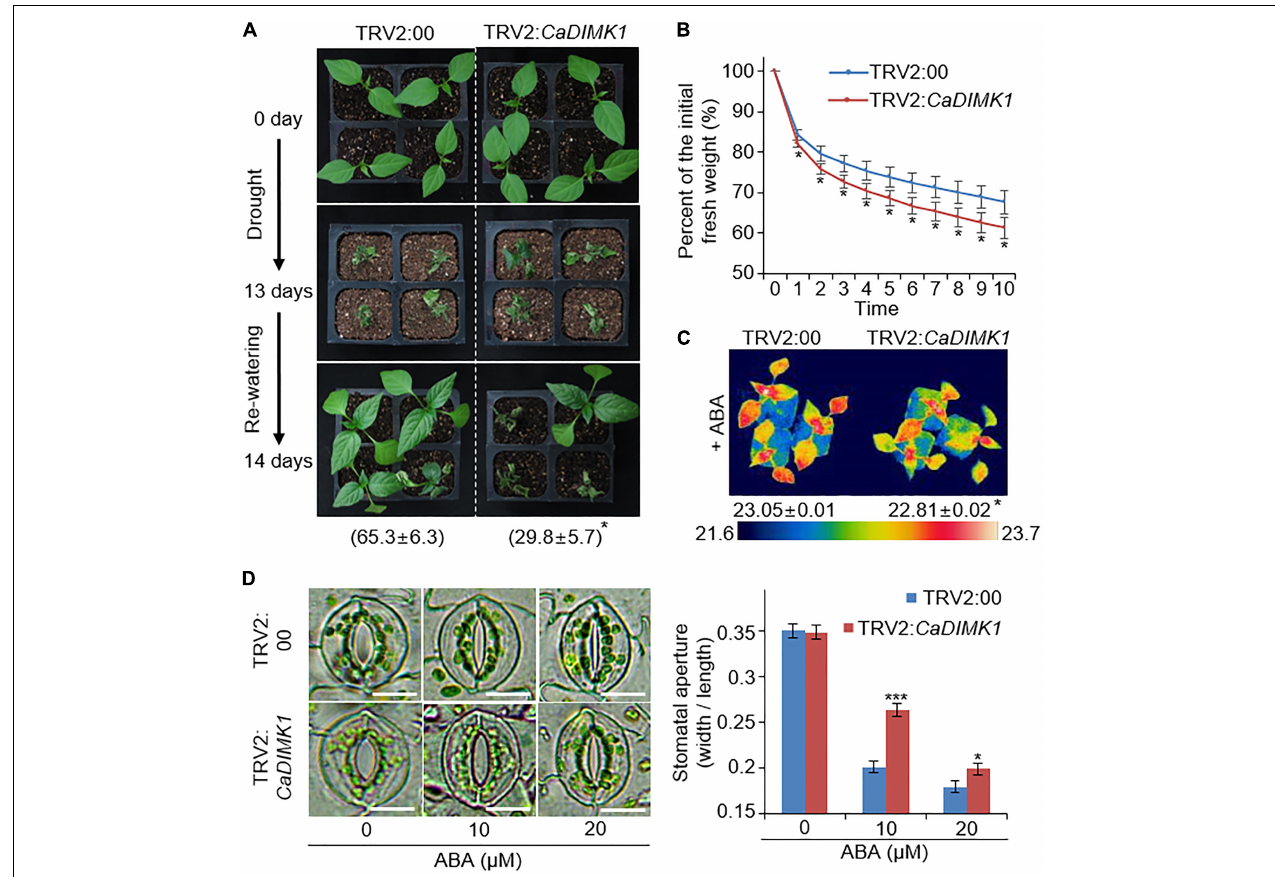
FIGURE 4 | CaDIMK1 mediated drought tolerance via CaDIMK1 -silenced pepper plants. (A) Drought sensitivity of TRV2: CaDIMK1 pepper plants. Three-week-old pepper plants expressed TRV2:00 and TRV2: CaDIMK1 constructs were grown in well-watered conditions (upper). The pepper was exposed to drought stress by withholding watering for 13 days (middle), followed by 1 day after rewatering (lower). The survival rates were counted at 1 day after rewatering. (B) Reduced fresh weight from the detached leaf tissues of TRV2:00 and TRV2: CaDIMK1 pepper plants during 10 h. (C) Reduced plant surface temperature of TRV2: CaDIMK1 pepper plants after 50 µ M ABA treatment. Values are mean ± SE with three independent experiments ( n = 10). (D) Reduced stomatal apertures of TRV2:00 and TRV2: CaDIMK1 pepper plants after various concentrations of ABA treatment. The stomata with guard cells were taken using a microscope when the stomatal pore size was measured. Leaves were incubated in stomata opening buffers with 0, 10, or 20 µ M ABA. Values are mean ± SE with three independent experiments ( n = 15). Asterisks indicate statistical differences between the TRV2:00 and TRV2: CaDIMK1 pepper plants according to Student’s t -test (* P < 0.05, *** P < 0.001). The scale bar represents 10 µ